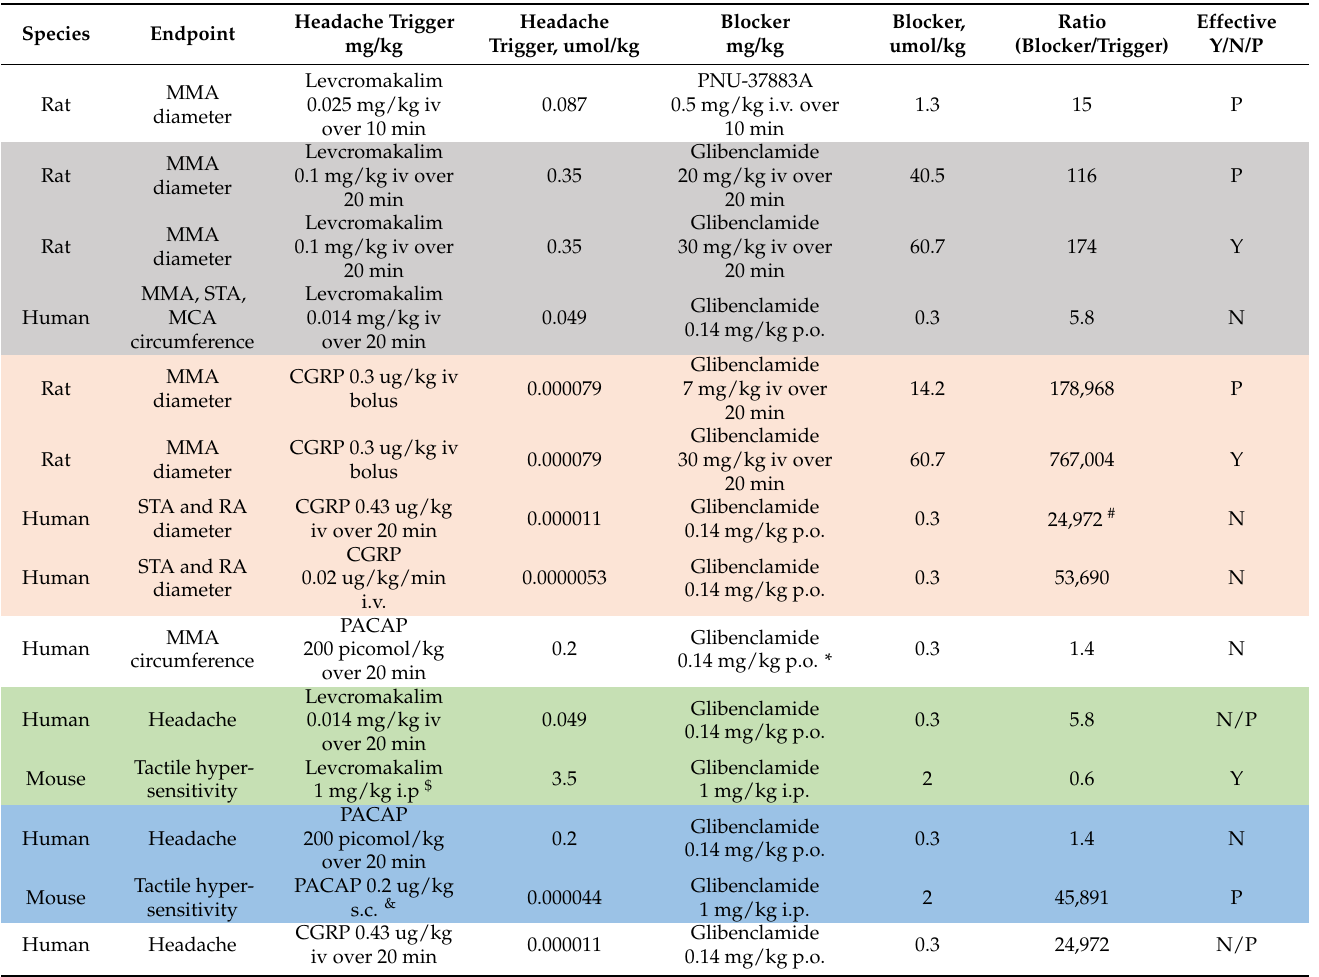
Table 2. Details of human and rodent studies on KATP channel blockage in different migraine models. Rows in same color are compared. The ratio of blocker/migraine trigger are used for rough assessment of effectiveness across models. Effective Y/N/P: Y = yes, N = no, P = par- tially. Percentwise changes of arterial circumference and diameter are the same. Thus, 20% change in diameter = 20% change in circumference. Dose mol/kg = (dose g/kg)/(MW g/mol),